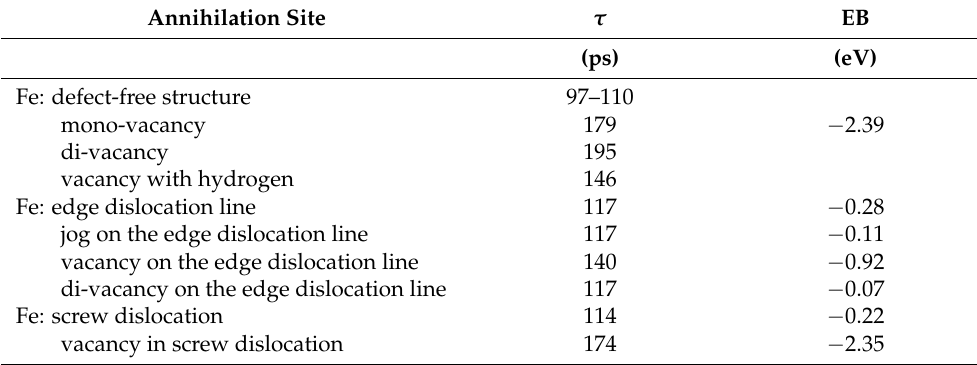
Table 2. Calculated lifetimes τ and binding energies EB of positrons trapped in the core region of dislocation line and defects associated with dislocation